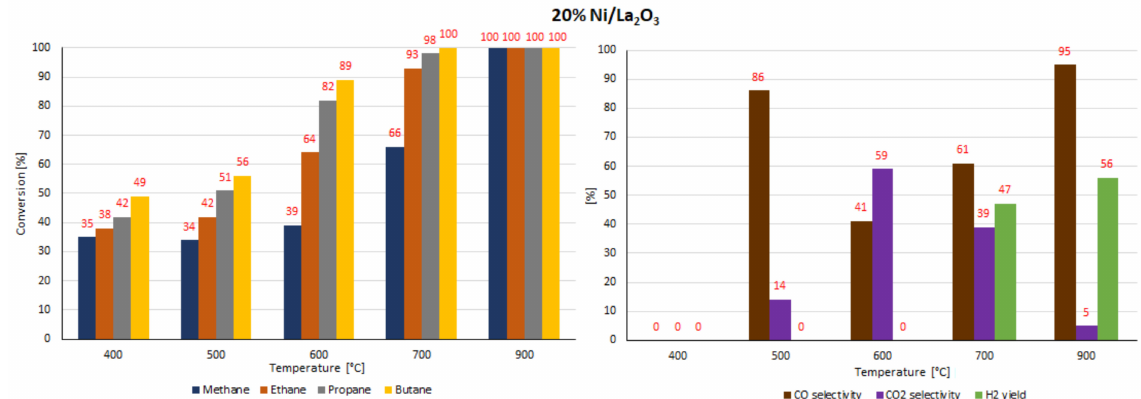
Figure 19. The activity results of the 20% Ni/La 2 O 3 catalyst in the OSR-LNG process.